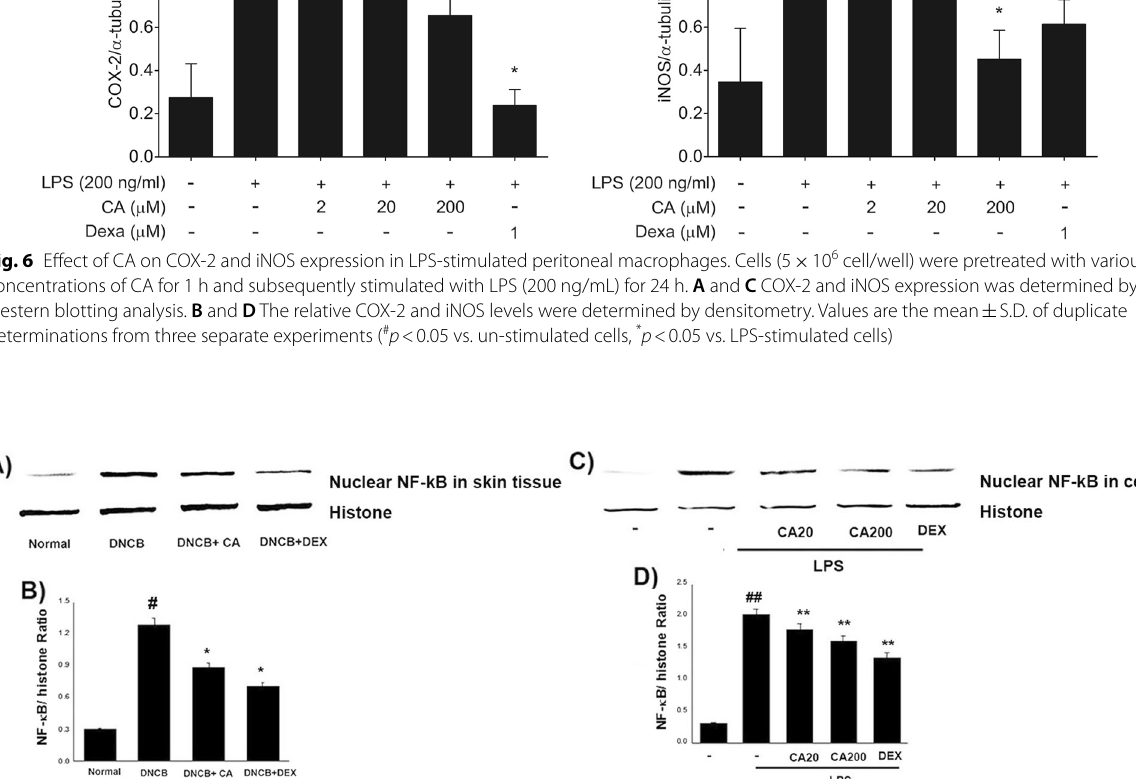
Fig. 7 Effect of CA on NF‑κB activation in AD‑like skin lesion and LPS‑stimulated mouse peritoneal macrophages. A The nuclear extract of skin tissue was isolated by Nuclear Extraction Reagents. The levels of NF‑κB p65 in nucleus were evaluated by western blot analysis. B The relative expression level of NF‑κB p65 was measured using an image analyzer. C Cells (6 10 6 ) were pretreated for 1 h with CA and then treated for × 1 h with LPS. The levels of NF‑κB p65 in cell nucleus were evaluated by Western blot analysis. D The relative expression level of NF‑κB p65 was measured using an image analyzer. The data represents the mean S.D. of three independent experiments ( # p < 0.05 vs. control group, * p < 0.05 vs. ± DNCB‑treated group, ** p < 0.05 vs. LPS‑stimulated